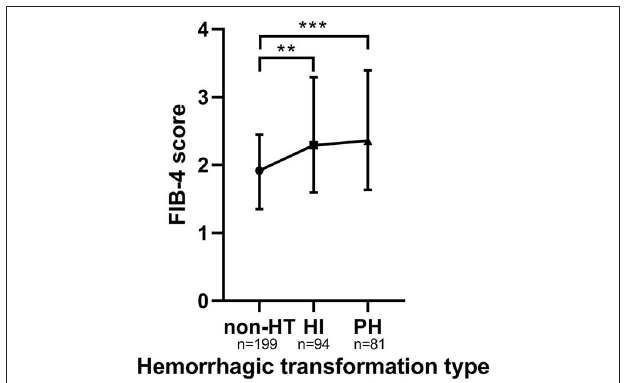
FIGURE 2 | The FIB-4 score in the subcategorized groups of HT. Each data point and error bar corresponds to the median and interquartile range of the FIB-4 score by the subcategorized groups of HT. HT, hemorrhagic transformation; HI, hemorrhagic infarct; PH, parenchymal hematoma. ** P < 0.01; *** P < 0.001.